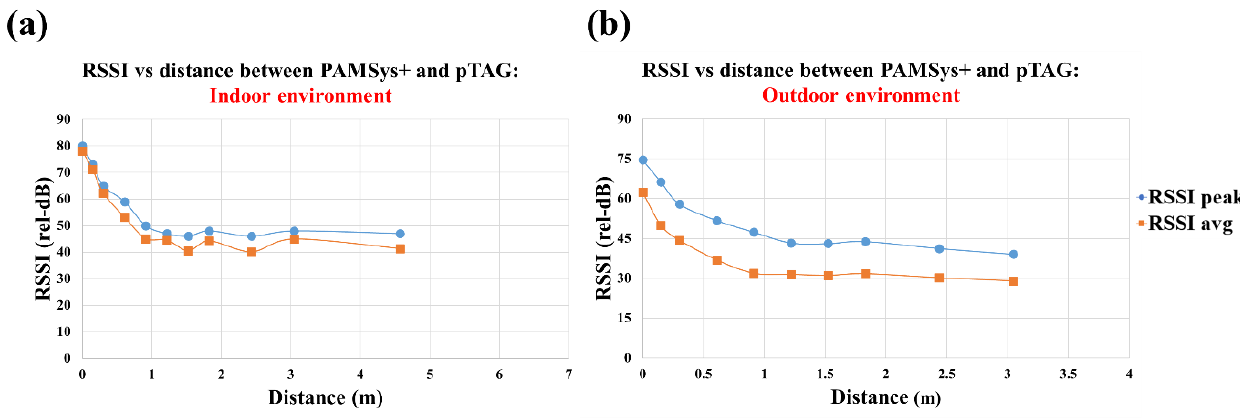
Figure 6. Results of the proximity detection test for the indoor ( a ) and outdoor ( b ) environments.